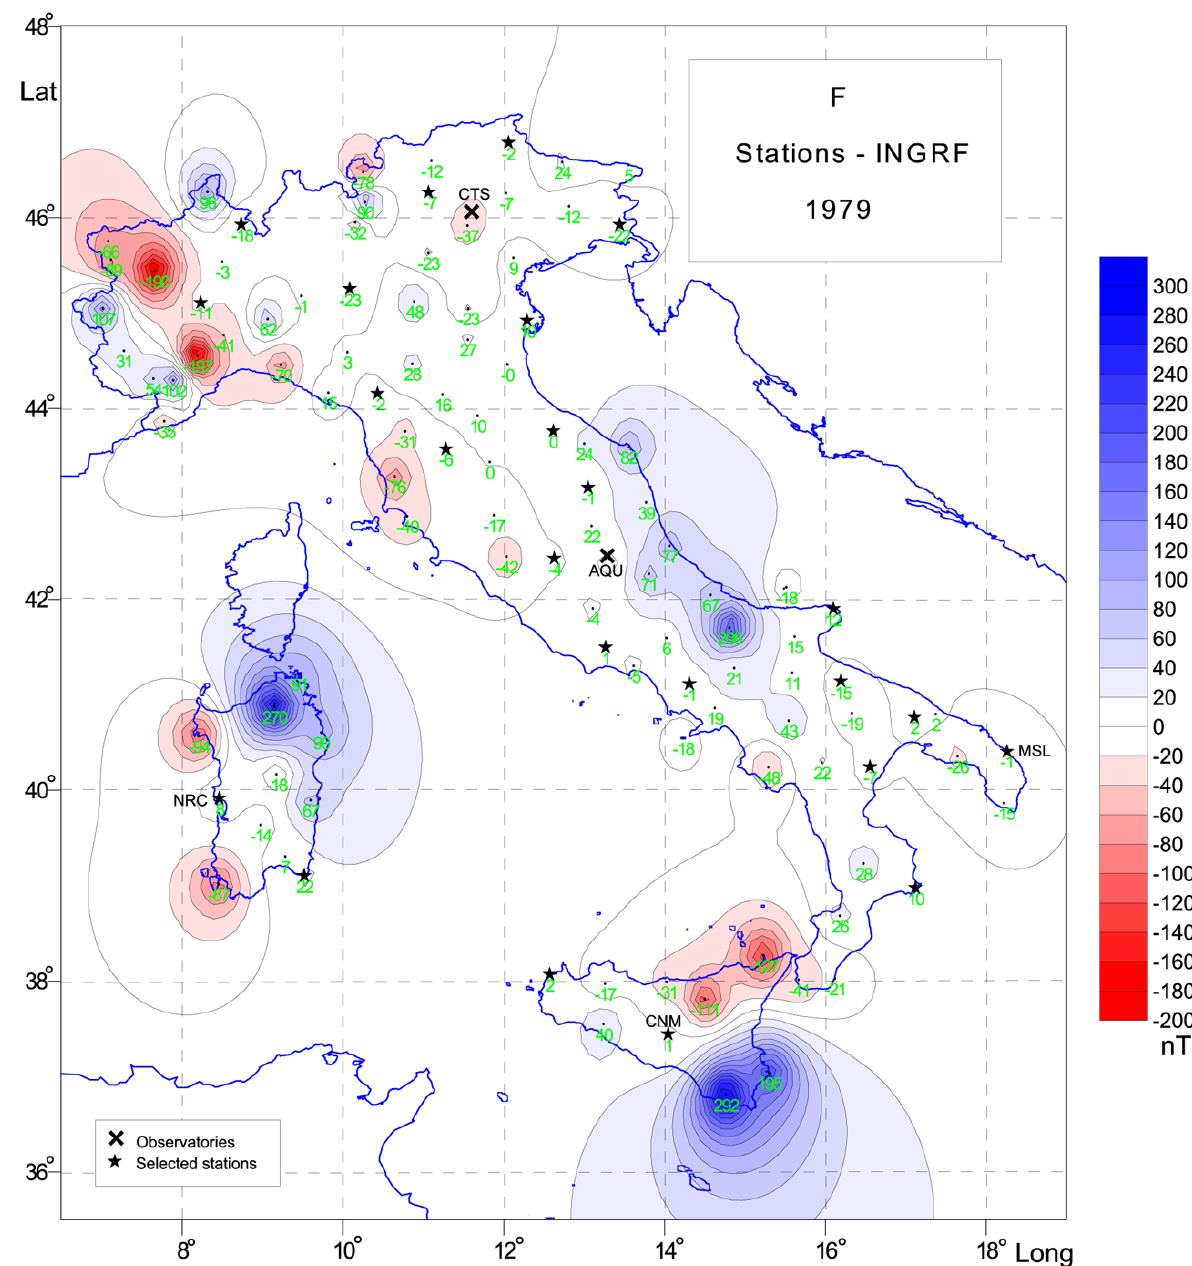
Figure 5. Anomalies of total field F at repeat stations with respect to INGRF at epoch 1979.0; units are nT; stars mark the location of repeat stations selected for a reduced network (see